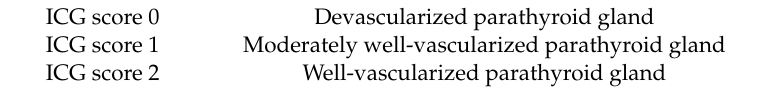
Table 3. Evaluation of parathyroid gland vascularization according to ICG